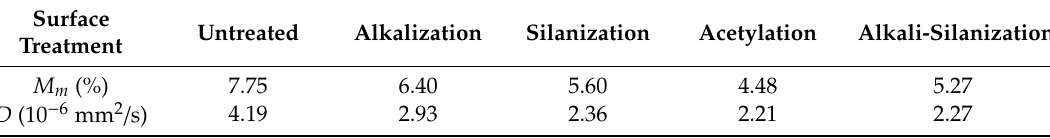
Table 1. Maximum weight increment percentage M m and di ff usion coe ffi cient D of FFRP. Surface